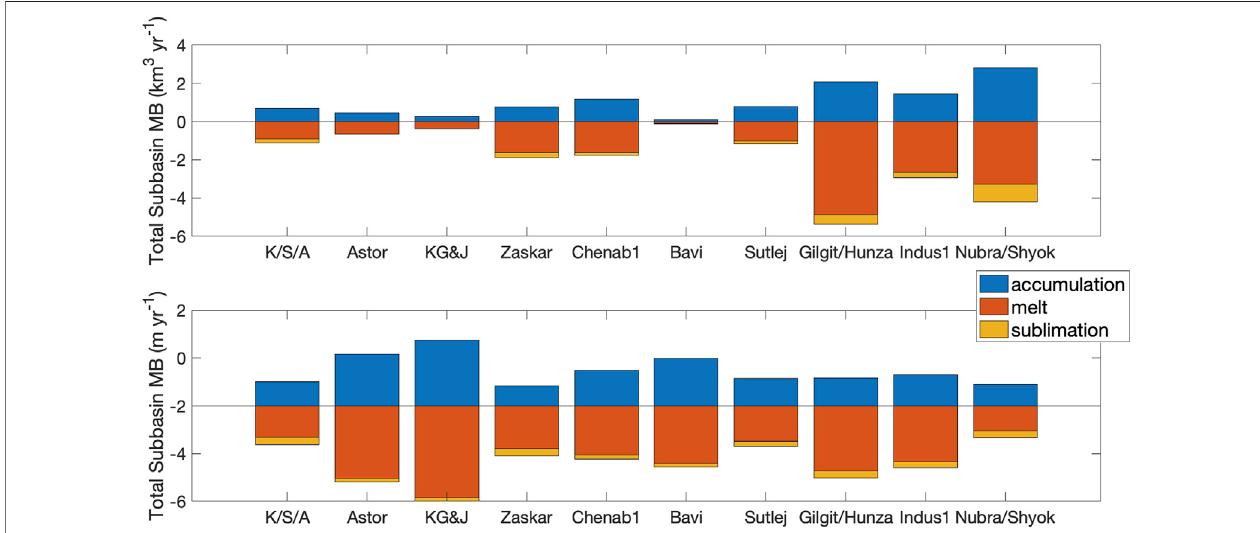
FIGURE 2 | The volumetric components of each subbasin ’ s annual average (2001 – 2013) clean glacier mass balance (MB), total (upper panel) and normalized for glacier area (lower panel). Melt (red) is the dominant mass balance term, with accumulation (blue) being less and sublimation (yellow) only a small part of the budget. Krishen Ganga and Jhelum are combined into a single basin (KG&J), and K/S/A is Kabul/Swat/Alingar.